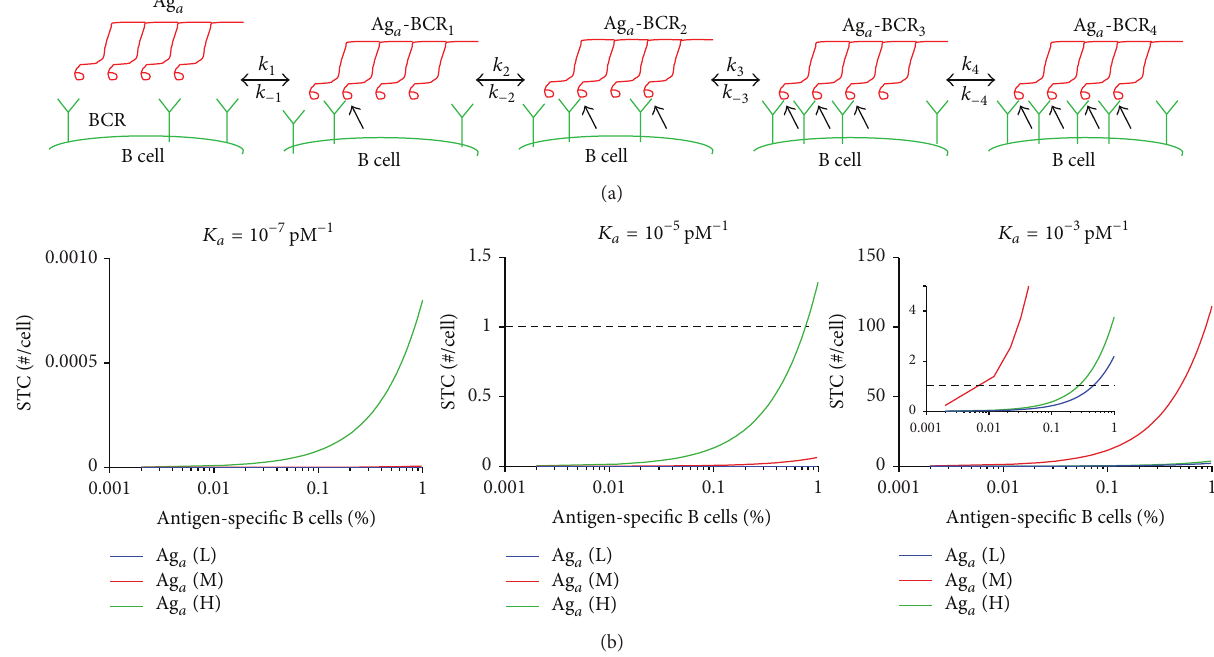
Figure 2: Significant number of STC per cell only forms under limited conditions. (a) Schematic representation of a tetravalent aggregate (Ag 𝑎 ) binding to BCRs to form Ag 𝑎 BCR 𝑖 , where 𝑖 denotes the number of BCRs bound to Ag 𝑎 . Black arrow points out the binding of Ag 𝑎 to a BCR. Each binding step 𝑖 is governed by its binding ( 𝑘 𝑖 ) and dissociation ( 𝑘 −𝑖 ) rates. (b) Simulated levels of STC formed per cell are plotted against percentage of antigen-specific B cells under low (L, 0.1pM), medium (M, 12 pM), and high (H, 1500pM) levels of total Ag 𝑎 , for binding affinity 𝐾 𝑎 = 10 −7 pM −1 (left panel), 10 −5 pM −1 (middle panel), and 10 −3 pM −1 (right panel). Inset in the right panel is the zoomed-in version of the plot. STC per B cell is defined as the number of aggregates that cross-link a minimum number ( 𝑠 ) of BCRs. Here 𝑠 = 2 and valency 𝑛 = 100 . The horizontal dashed line denotes one